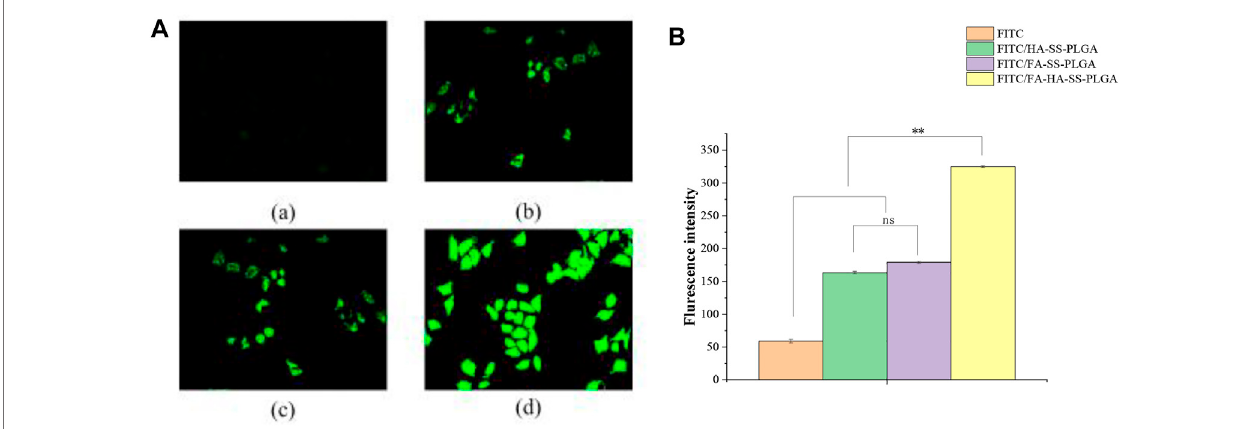
FIGURE 9 | MCF-7 cell uptake study. (A) Uptake of free fl uorescein isothiocyanate (FITC) (a), FITC/HA-SS-PLGA (b), FITC/FA-SS-PLGA (c), and FITC/FA-HA-SS- PLGA(d)inMCF-7cellswasobservedby fl uorescenceinvertedmicroscope(scale:50 μ m). (B) Theaverage fl uorescenceintensityofeachadministrationgroupinMCF- 7 cells was detected by fl ow cytometry. Data were expressed as mean ± SEM ( n =